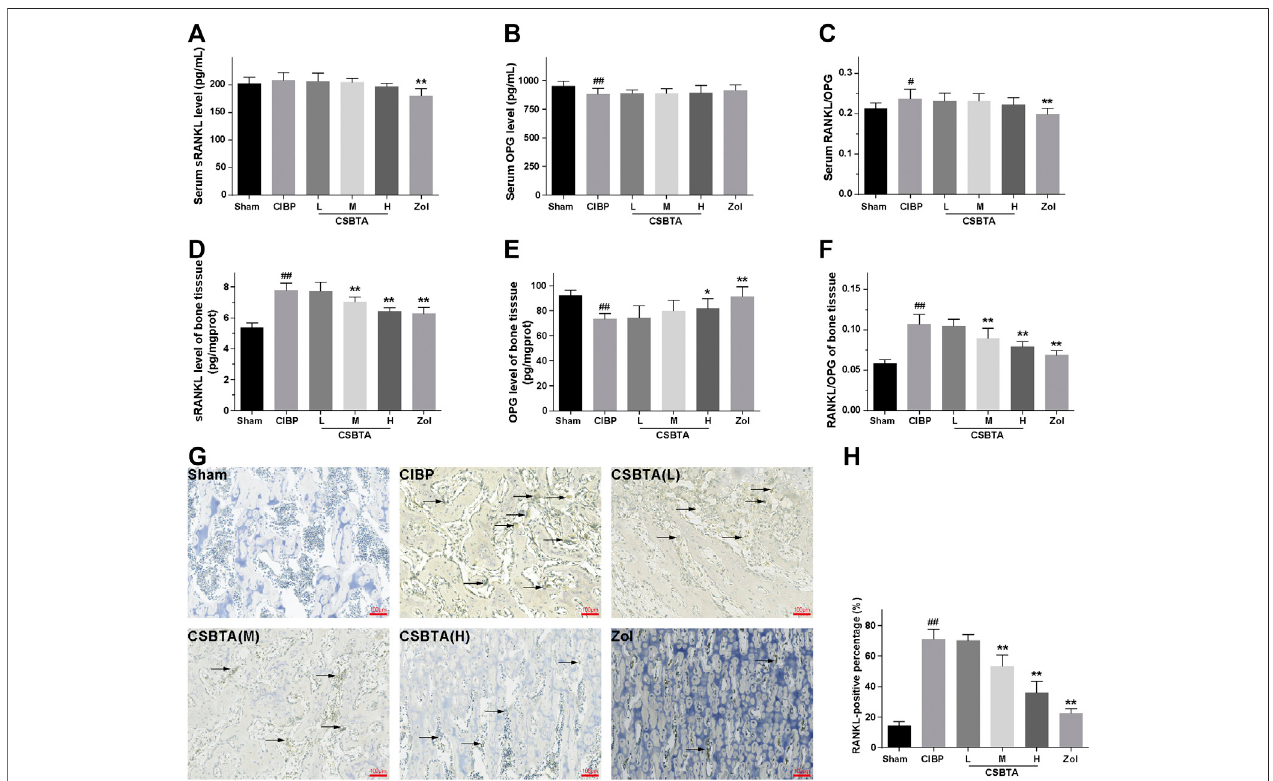
FIGURE 3 | Effects of CSBTA on rat RANKL/OPG system at the 30th day after tumor cell inoculation. The level of soluble receptor activator of nuclear factor κ B ligand (sRANKL, (A) and osteoprotegerin (OPG, (B) in the serum, OPG (D) and sRANKL (E) in the tibia tissue were measured by ELISA kit. sRANKL/OPG ratio in the serum (C) and tibiae (F) were further calculated ( n (cid:2) 6). (G) Immunohistochemical analysis of the spread of RANKL in tibiae of rats at 30-days after tumor cell inoculation ( n (cid:2) 5). (H) TheRANKL-positivepercentagewerecalculated( n (cid:2) 5).Datawasexpressedasmeans ± SDandanalyzedbyone-wayANOVA. # p < 0.05, ## p < 0.01vs. the Sham group, * p < 0.05, ** p < 0.01 vs. the CIBP group. Scale bar (cid:2) 100 μ